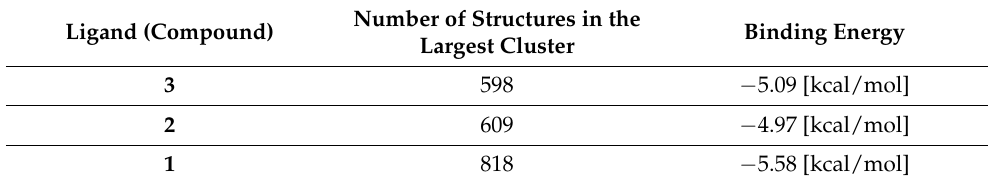
Table 6. Docking results characterized by number of structures in the largest cluster and binding energy. Number of Structures in the Ligand (Compound) Binding Energy Largest Cluster